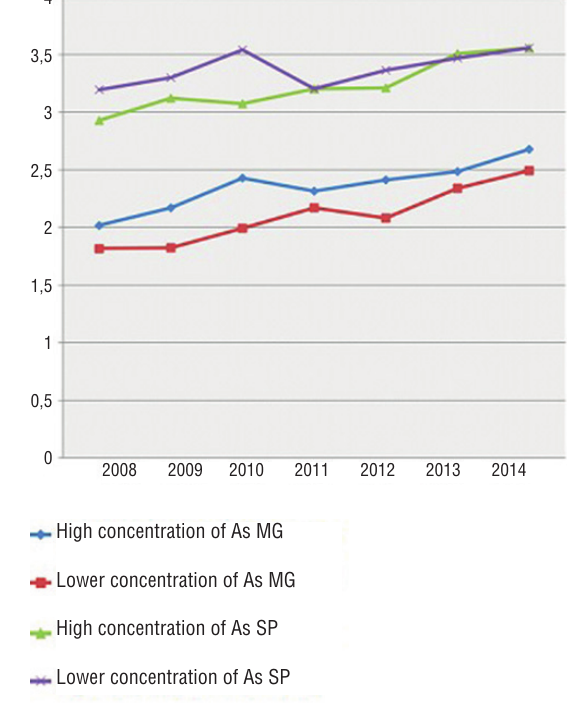
figure 4 - Mortality due to bladder neoplasia in regions with lower and higher concentration of arsenic in the states of São paulo and Minas